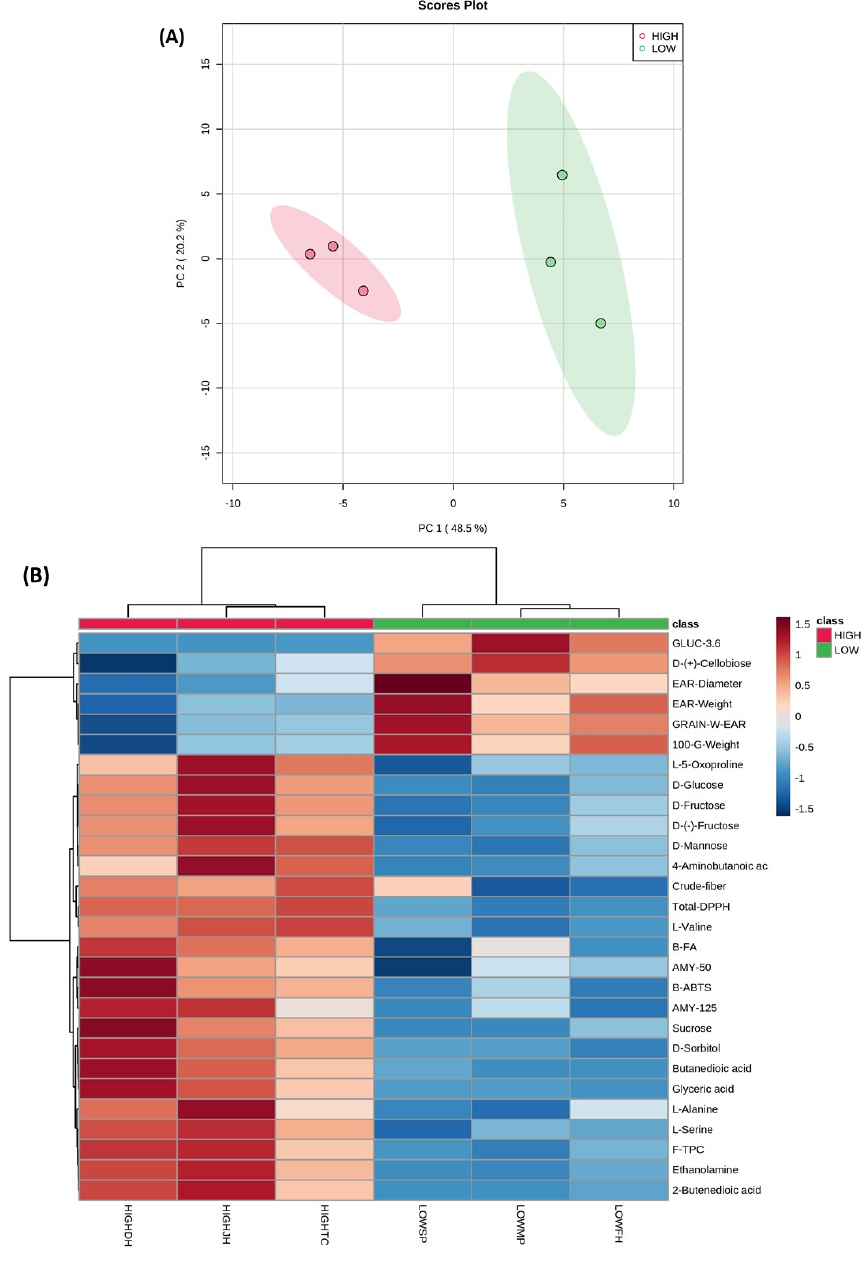
Figure 1. Principal component analysis (PCA) score plot ( A ) and heat map ( B ) considering significant variables from purple corn kernel samples grown at two different geographical locations (highland, HIGH and lowland, LOW). Variables in legend: GLUC-3.6, α -glucosidase inhibition (3.6 mg); GRAIN- W-EAR, kernel weight per ear; Total-DPPH, total DPPH antioxidant capacity; B-FA, bound ferulic acid; AMY-50, α -amylase inhibition (50 mg); AMY-125, α -amylase inhibition (125 mg); B-ABTS, bound ABTS antioxidant capacity; F-TPC, free total phenolic